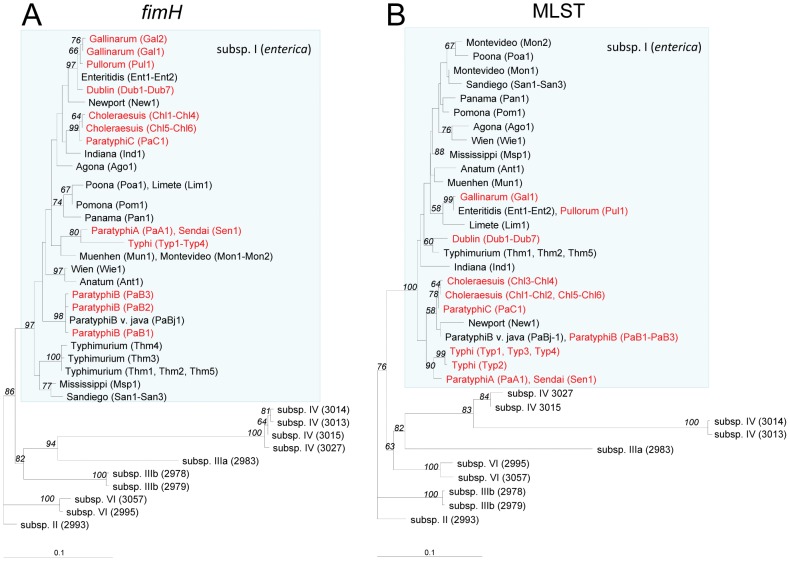
Maximum-likelihood DNA phylograms of S. enterica fimH and concatenated MLST loci (aroC, hisD and thrA).The fimH tree (A) was built based on an alignment of fimH sequences amplified from 55 isolates including 45 different strains of subspecies I and 10 strains of subspecies II–VI (for details see Table 1). Five additional alleles of fimH obtained from GenBank (S. Typhimurium AJB3 (Thm3), S. Typhimurium LB5010 (Thm4), S. Gallinarum 287/91 (Gal1) and 589/02 (Gal2), and S. Paratyphi C 49 [RKS4594] (PaC1) were included. The MLST loci tree (B) was built on an alignment of concatenated sequences of three genes (aroC, hisD and thrA) obtained for 57 study strains. The trees shown were rooted using S. enterica subsp. II (2993). The italicized values along the branches denote % bootstrap values based on 1000 runs (the bootstrap proportions along the terminal branches separating isolates within single serovars as well as the ones below 50% are not shown). Systemically invasive serovars are shown in red and non-invasive serovars are shown in black. Strain tags are as used in the text.